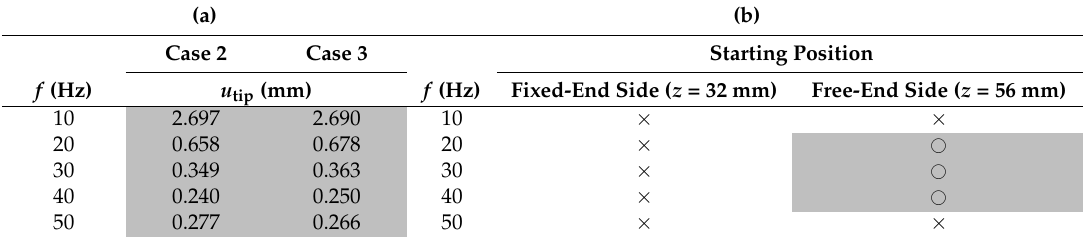
Table 5. Relationship between ( a ) Tip displacement and ( b ) Movement of the proof mass corresponding to input frequency (Type